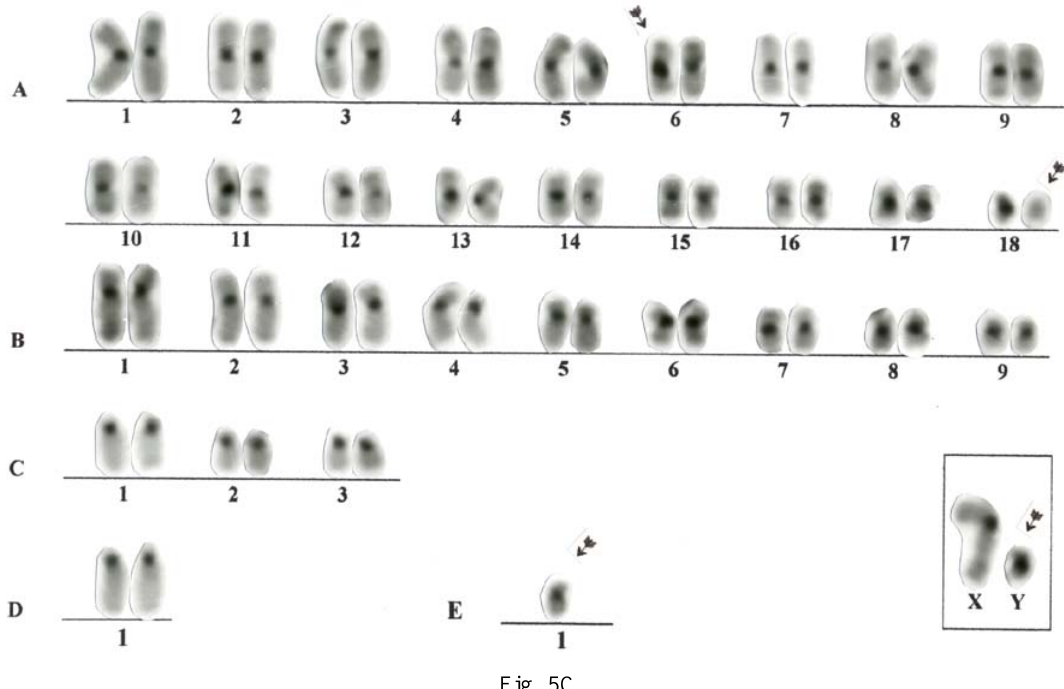
Fig. 5–BandingC(CBG)standardinthelineages2n=64and2n=65. A)andC)thearrowspointtooneofthehomologuesfromthepair A18, lacking the heterochromatical block ( D. prymnolopha and Dasyprocta sp., respectively.); A), B) and C) one of the homologues from the pair A6 had an increasing of the heterochromatical block ( D. prymnolopha, D. leporina and Dasyprocta sp., respectively); A) and C) the supernumerary chromosome with a constitutive heterochromatin in the pericentromeric region ( D. prymnolopha and Dasyprocta sp., respectively). B) and C) the arrows point to the Y chromosome, almost totally heterochromatical ( D. leporina and Dasyprocta sp.,